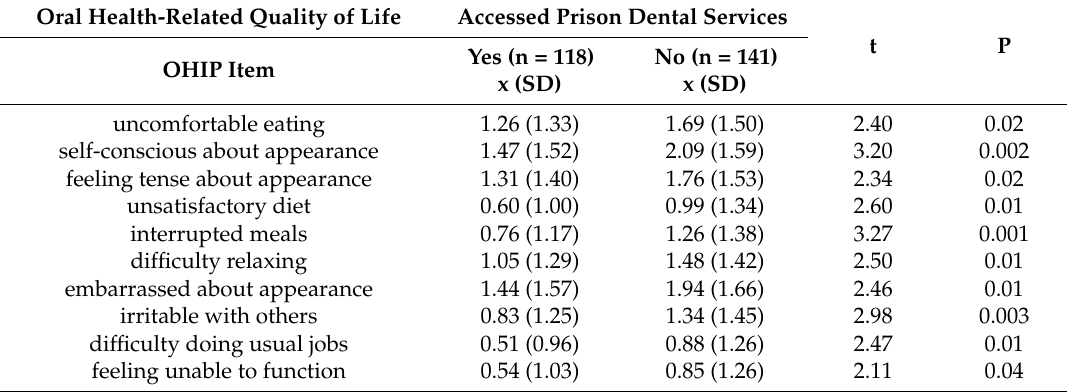
Table 1. Comparison of Oral Health Impact Scale (OHIP) items by access to prison dental services. Oral Health-Related Quality of Life